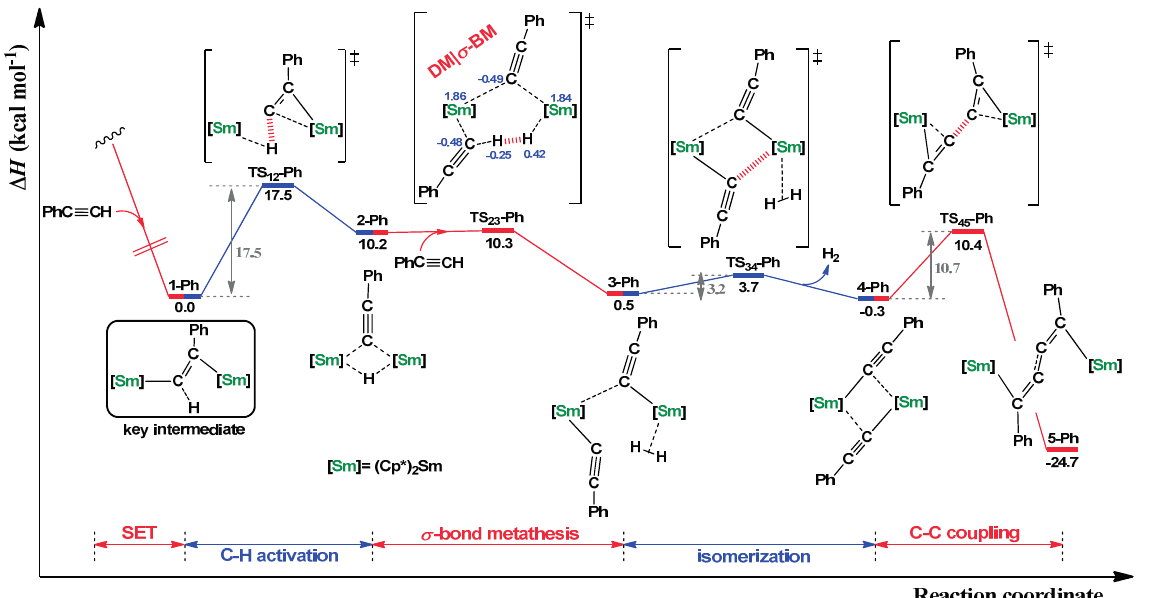
Figure 3. Enthalpy energy Δ H (kcal·mol − 1 ) profile for the formation of the corresponding trienediyl complex using PhC ≡ CH as substrate and (Cp * ) 2 Sm as a precursor (mechanism C). Cp * ligands are omitted for clarity. Numbers in blue correspond to natural